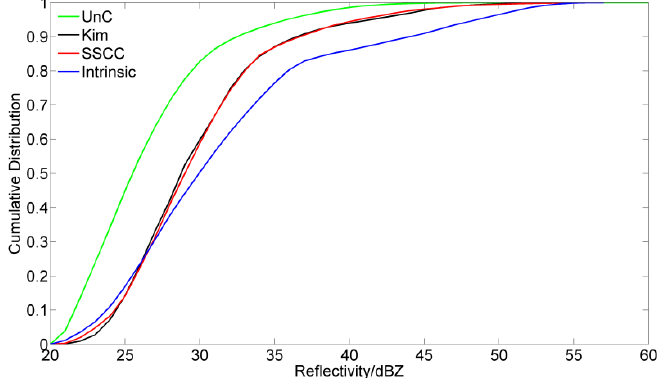
Figure 17. Cumulative distribution of reflectivity for the stratiform rain with embedded convection.